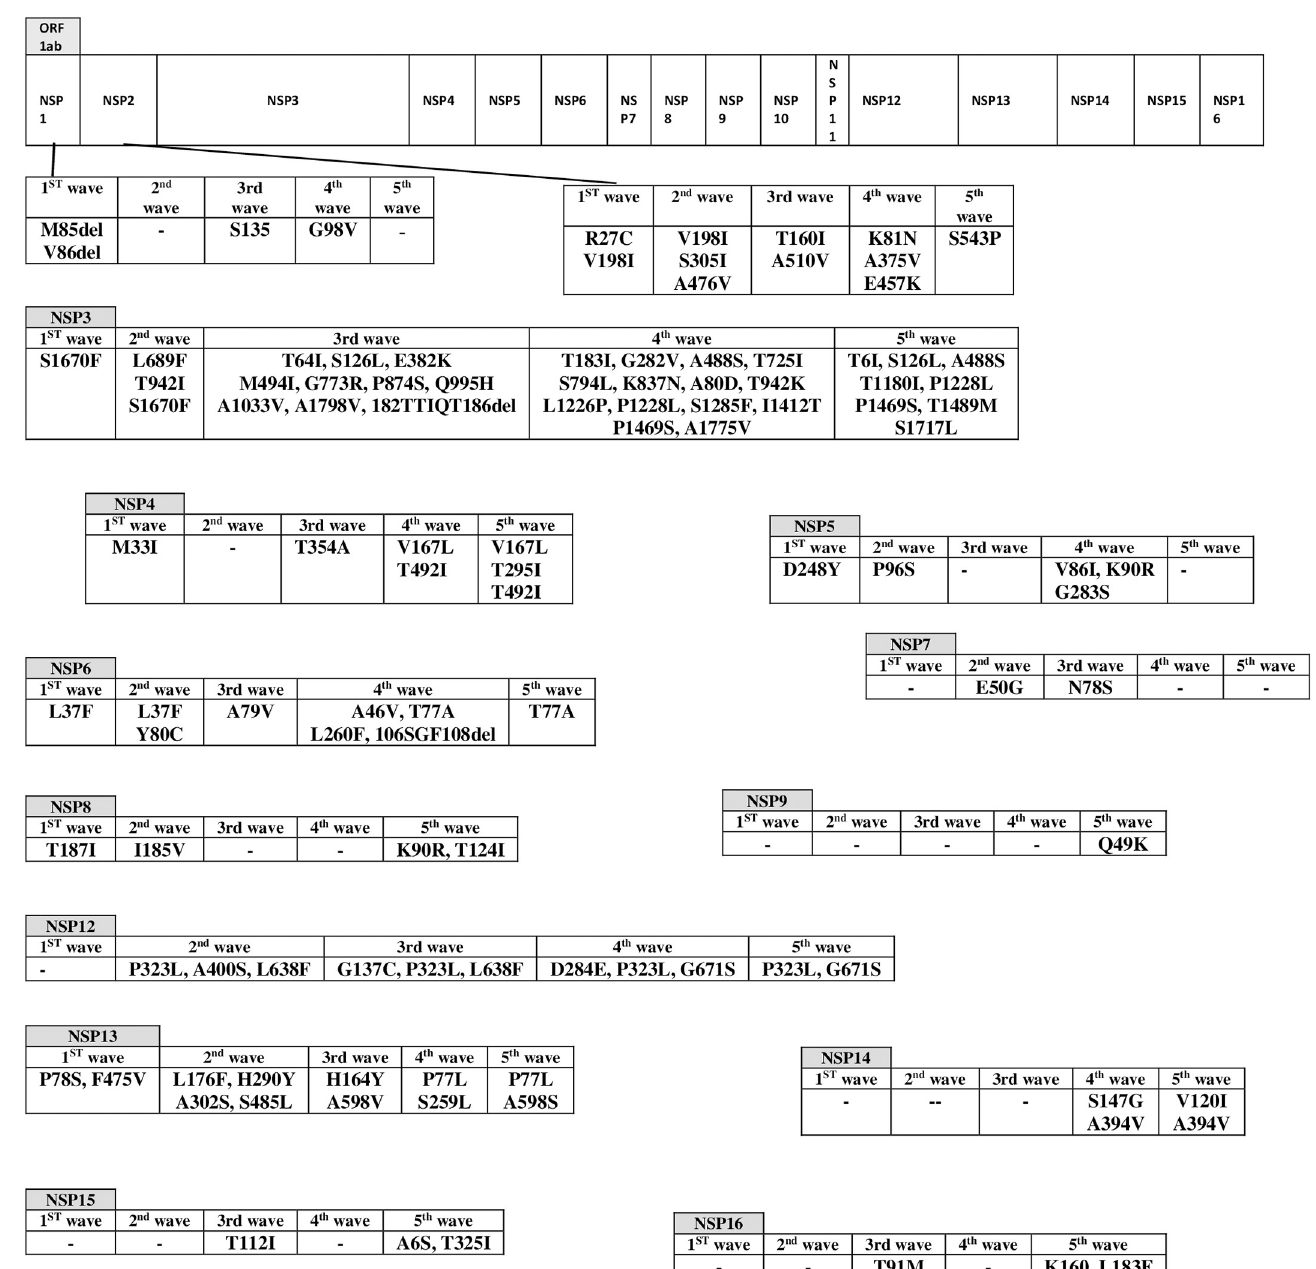
Fig 1. The substitutions of nonstructural proteins during the five waves of SARS-CoV2 pandemic in Iran.